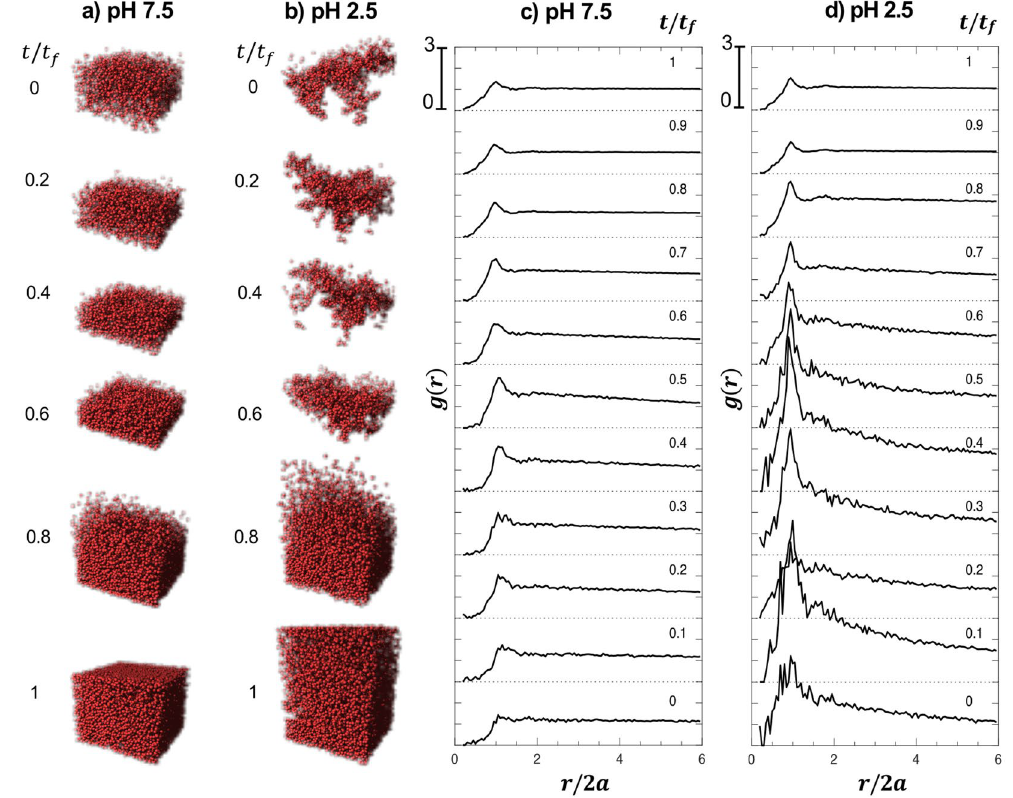
Figure 4. Rendered microstructure of observed particles through the drying process for ( a ) pH 7.5 and ( b ) pH 2.5 at arbitrary t/t f . The average spatial distribution of particles is indicated as radial distribution function, g(r), during drying suspensions of 𝜙 0 = 0.05 and w PEO = 0.05 at ( c ) pH 7.5 and ( d ) pH 2.5, as a function of normalized separation distance r/2a, where a is a particle